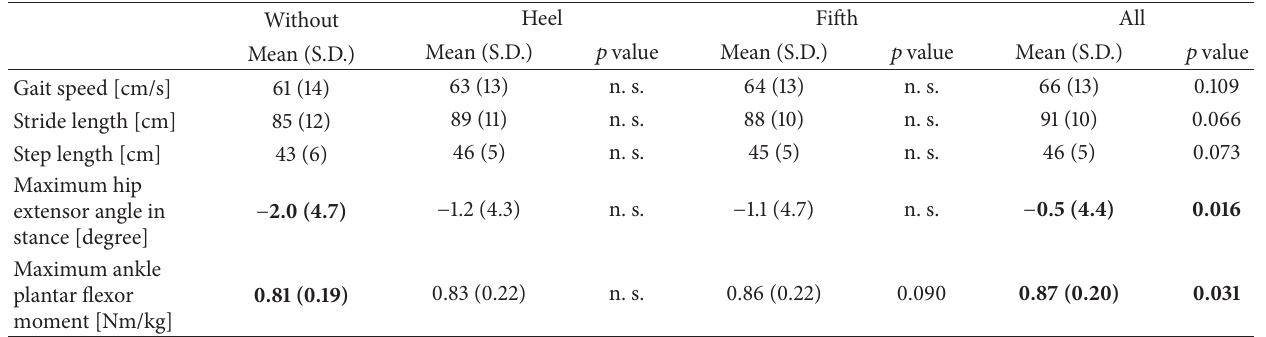
Table 3: The mean and standard deviation of temporal spatial, kinetic, and kinematic data on affected side in the four conditions.